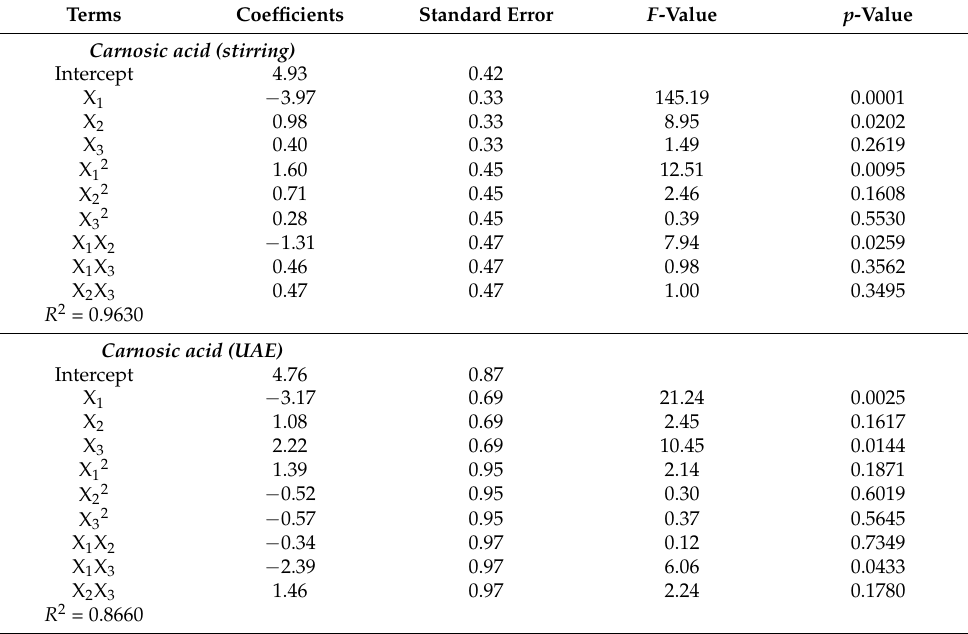
Table A1. Regression coefficient of polynomial function of all response surfaces for carnosic